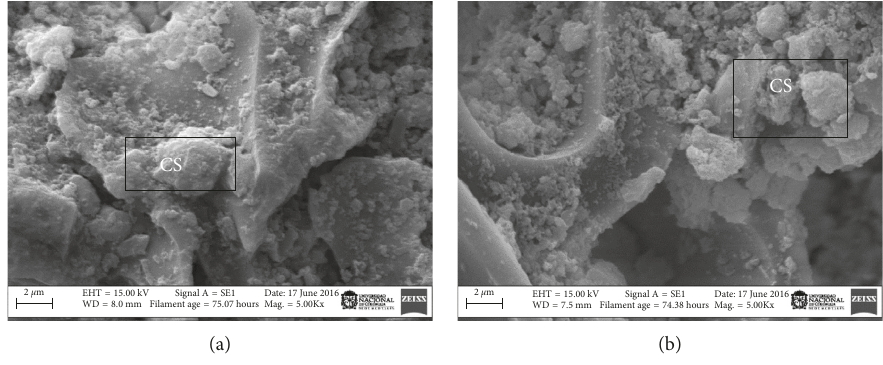
Figure 14: Aggregate zone of (a) PEC5S-0 and (b)